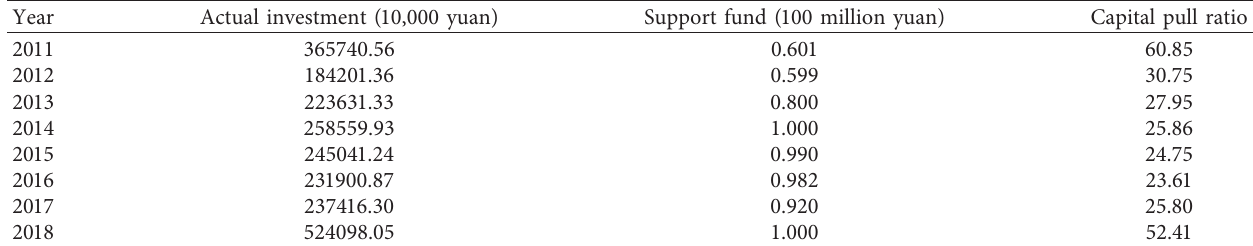
Table 3: Capital pull ratio from 2011 to 2018.